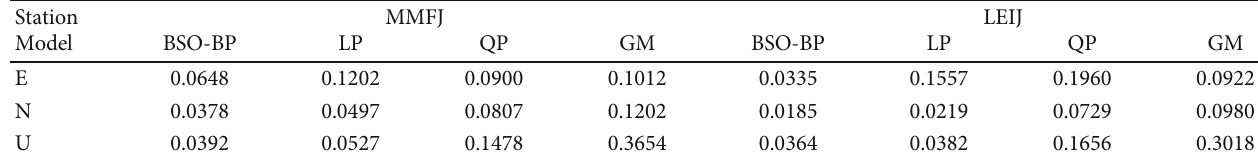
Table 7: The positioning accuracy statistics of static